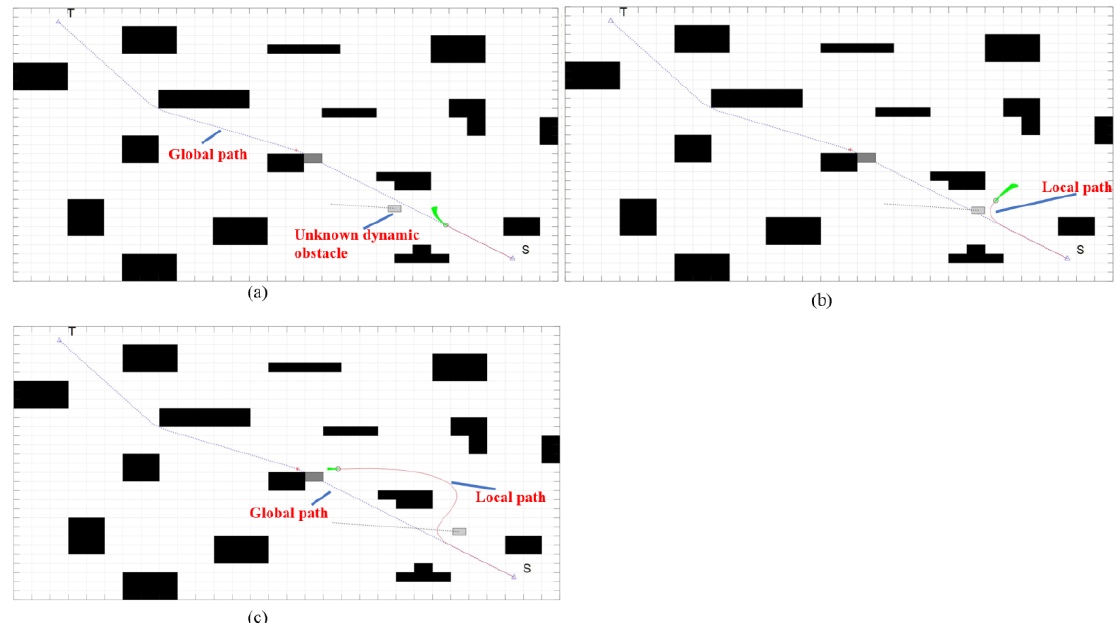
Figure 14. Dynamic path planning algorithm for FAGV returns a global path after avoiding dynamic obstacles. ( a ) FAGV detects a dynamic obstacle that is about to collide. ( b ) FAGV drives along the local path for obstacle avoidance. ( c ) FAGV returns the global path after obstacle avoidance.